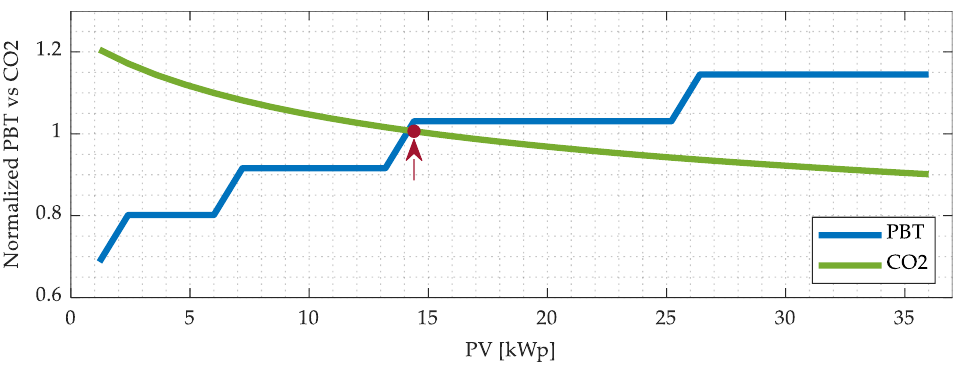
Figure 6. Normalized PBT vs. total CO2 emissions for Scenario 4.